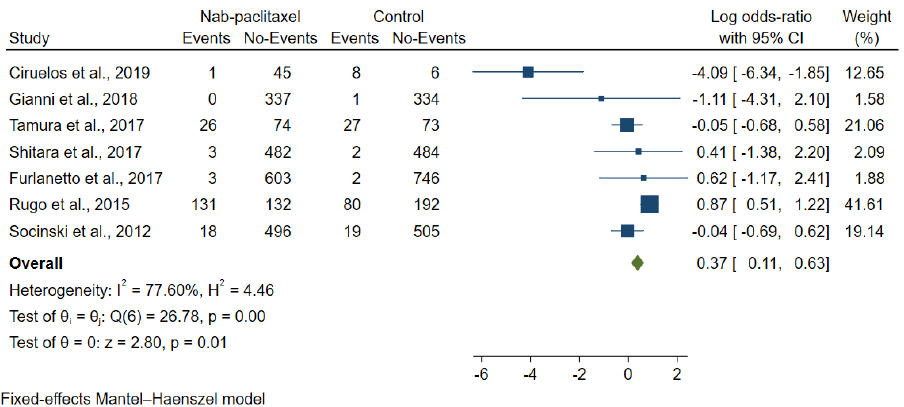
Fig. 4. The forest plot showed the odds ratio of deaths due to treatment-related adverse